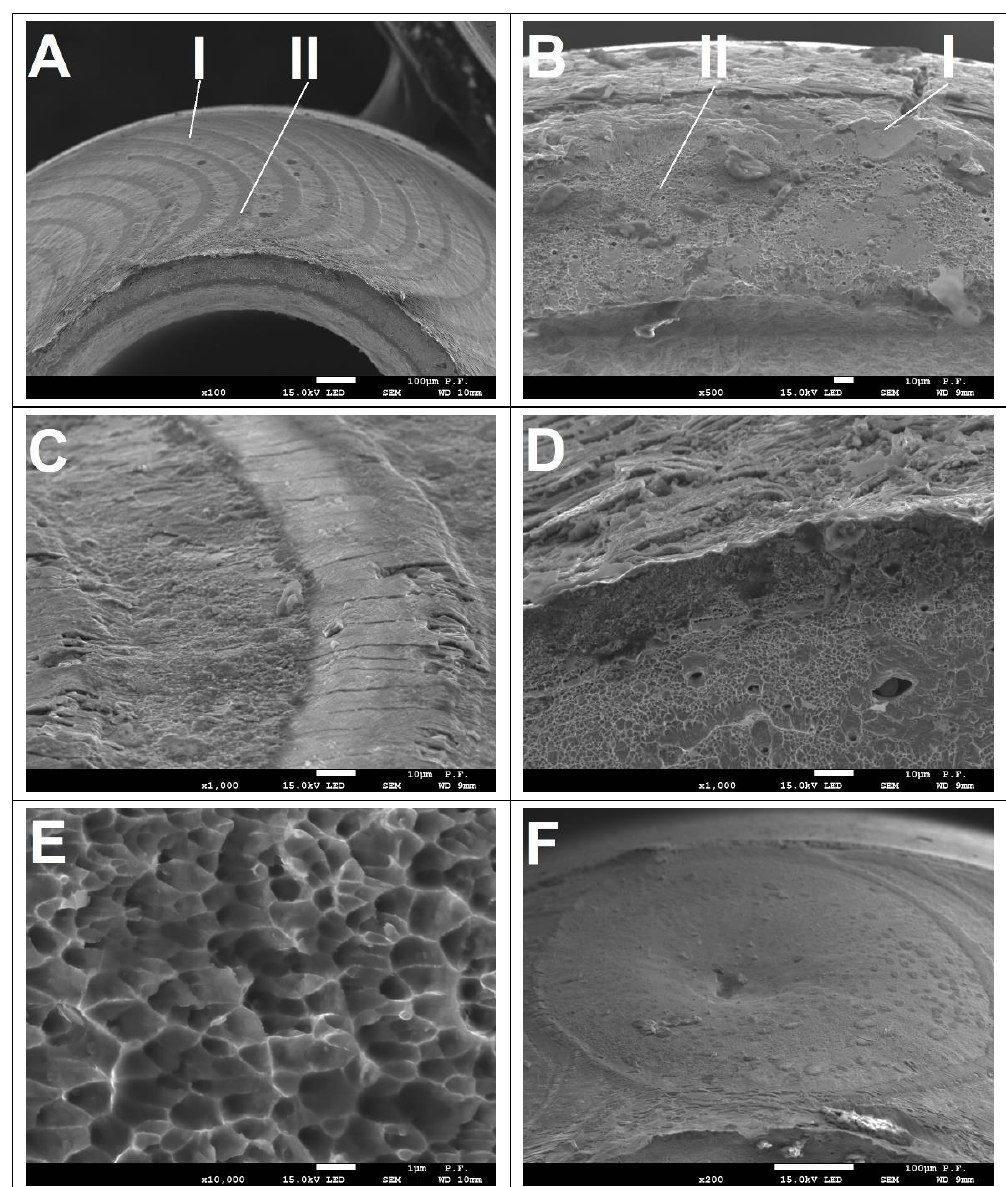
Figure 12. Morphology of the sample fracture after breaking: ( A ) 500× magnification; ( B ) 100× mag- nification; ( C ) 1000× magnification; ( D ) 500× magnification; ( E ) 10,000× magnification; ( F ) 200× mag- nification.